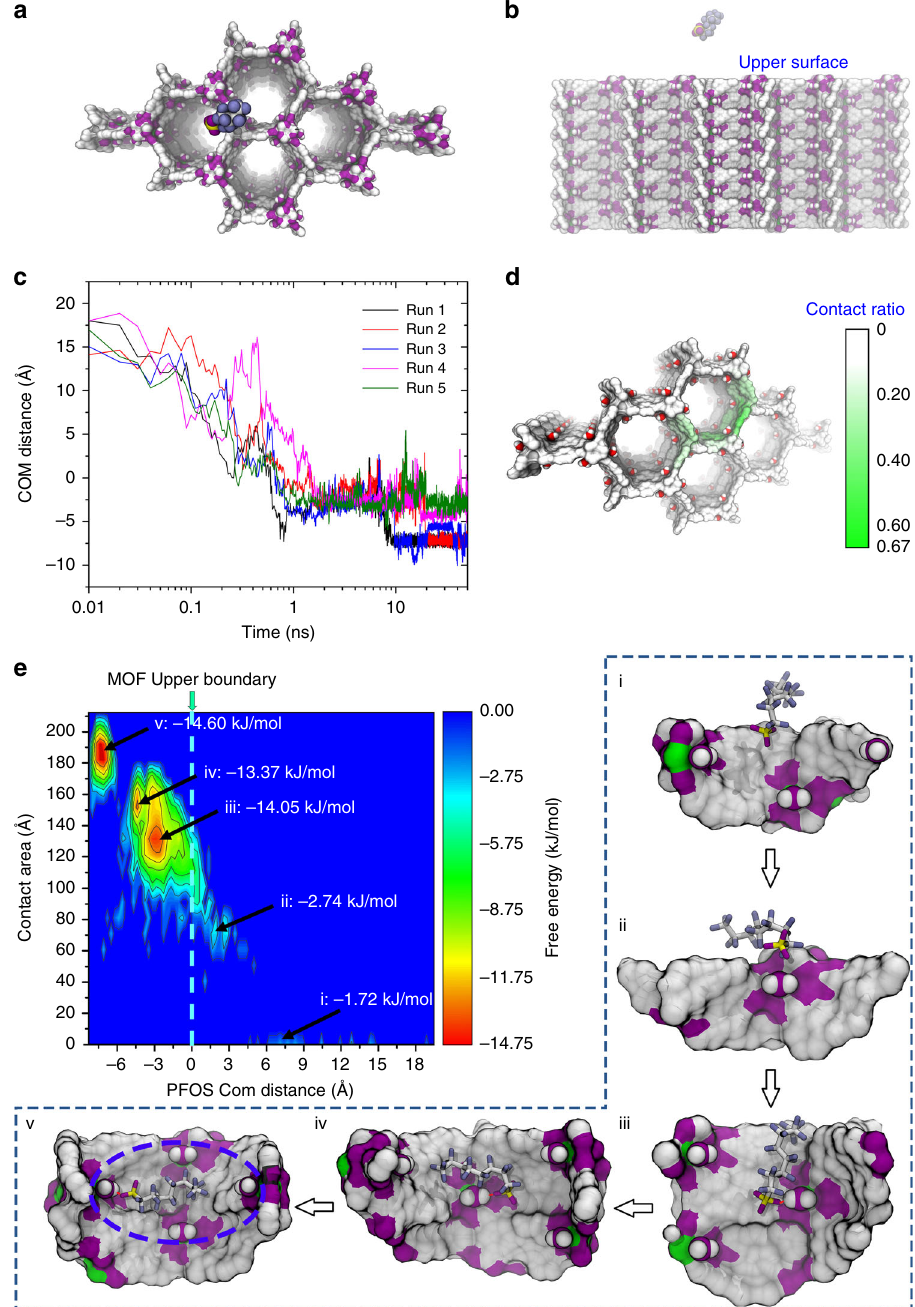
Fig. 5 MD simulations on the binding pattern and adsorption pathway of PFOS into SCU-8. The top a and side b view of simulation system, for clarity only PFOS and SCU-8 are shown; c the distance between center of mass (COM) of PFOS and the upper surface of SCU-8 for all fi ve independent runs; d the contact ratio between PFOS and SCU-8; e the PFOS binding free energy surface (in kJ/mol), which is estimated by W( A cont , D com ) = − K b T ln P ( A cont , D com ), where P is probability of fi nding the PFOS at position ( A cont , D com ). The color bar for the free energy (in kJ mol − 1 ) is given on the right panel fi gure. Snapshots i – v highlighted by the dashed box represent fi ve speci fi c PFOS-SCU-8 binding modes correspond to the fi ve free energy